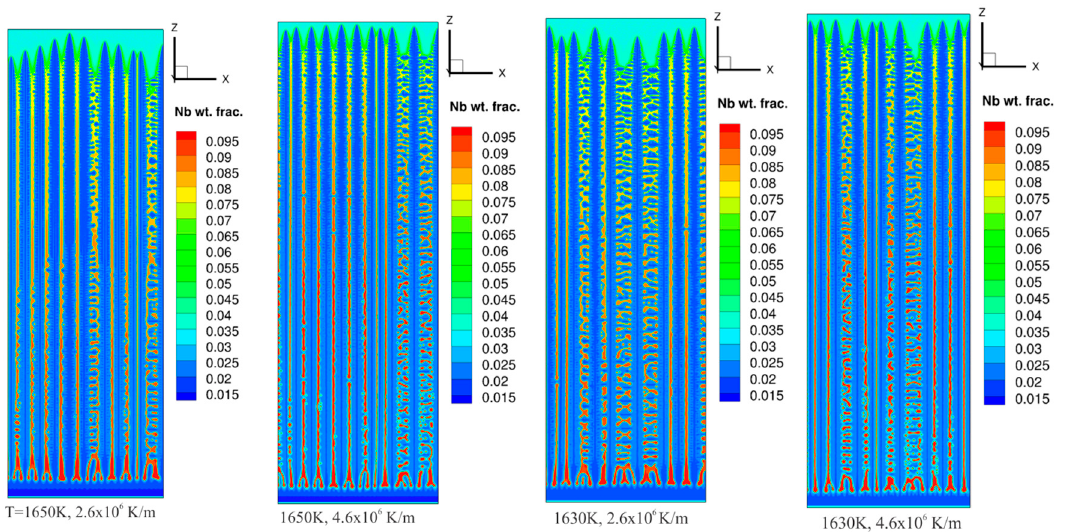
Figure 13. Effect of initial undercooling at the s-l interface and the temperature gradient in the liquid on the solidification morphology. D = 1 × 10 − 9 m 2 /s and sd =